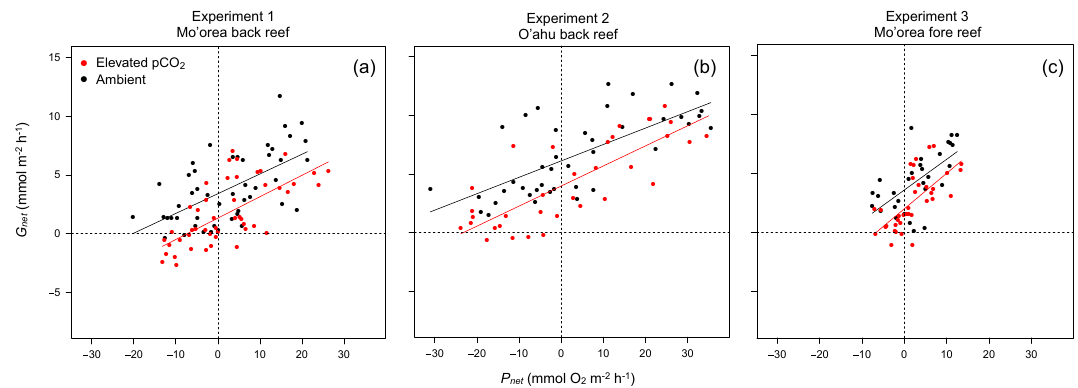
Figure 4. Variations in G net as a function of P net at the three study sites: (a) Mo’orea back reef, (b) O’ahu back reef, and (c) Mo’orea fore reef. Relationships were determined under control p CO 2 (400µatm, black points and lines) and elevated p CO 2 ( ∼ 1200µatm, red points and lines). For the three communities and the two p CO 2 levels, the slopes of the linear relationships between P net and G net were